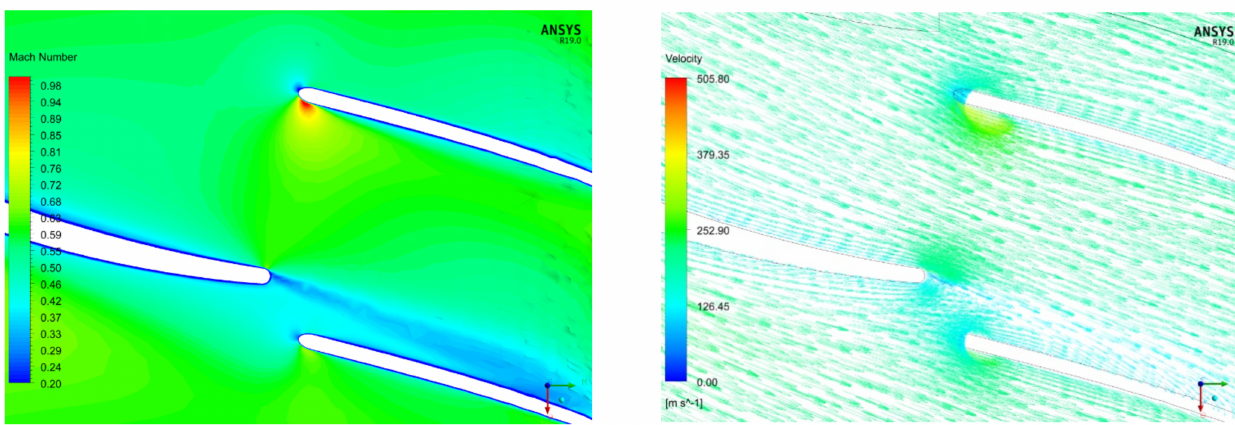
Figure 17. Effects of the incidence correction m r = 0.36. Countour of Mach number ( left ) and velocity vector plot ( right ).